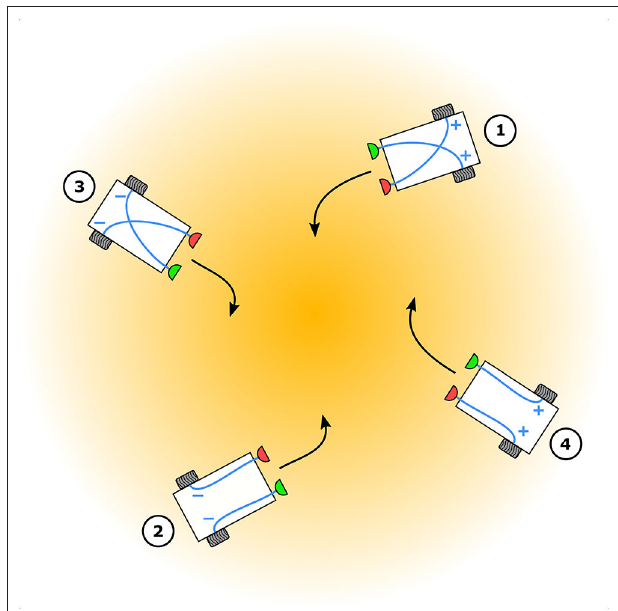
FIGURE 1 | Elementary Braitenberg vehicle models for animal tropotaxis. Depending on the nature of the sensorimotor couplings (blue), “+” implying excitation and “ − ” implying inhibition, between the sensors (red and green) and the wheels (gray) vehicles 1 and 2 exhibit positive tropotaxis toward while vehicles 3 and 4 exhibit negative tropotaxis away from the stimulus source (orange) centered in the stimulus